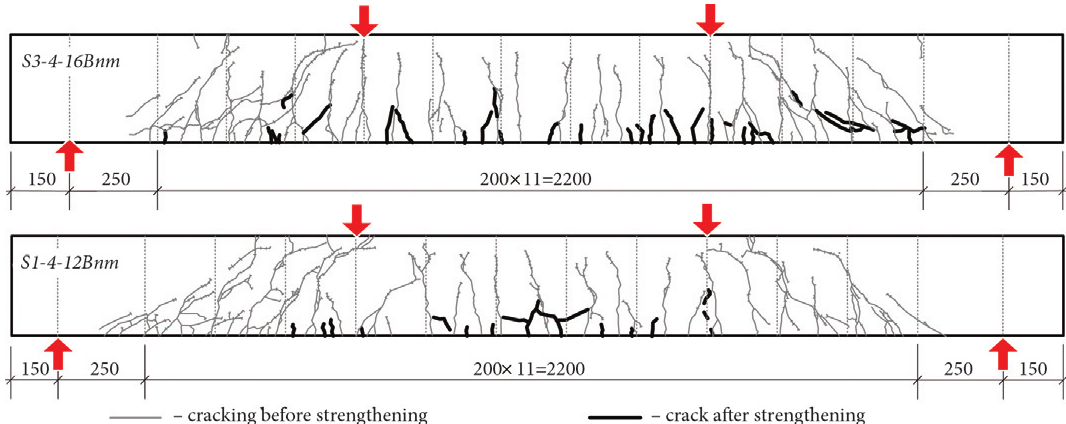
Fig. 5. Crack pattern of the tested specimens (measuments in mm)